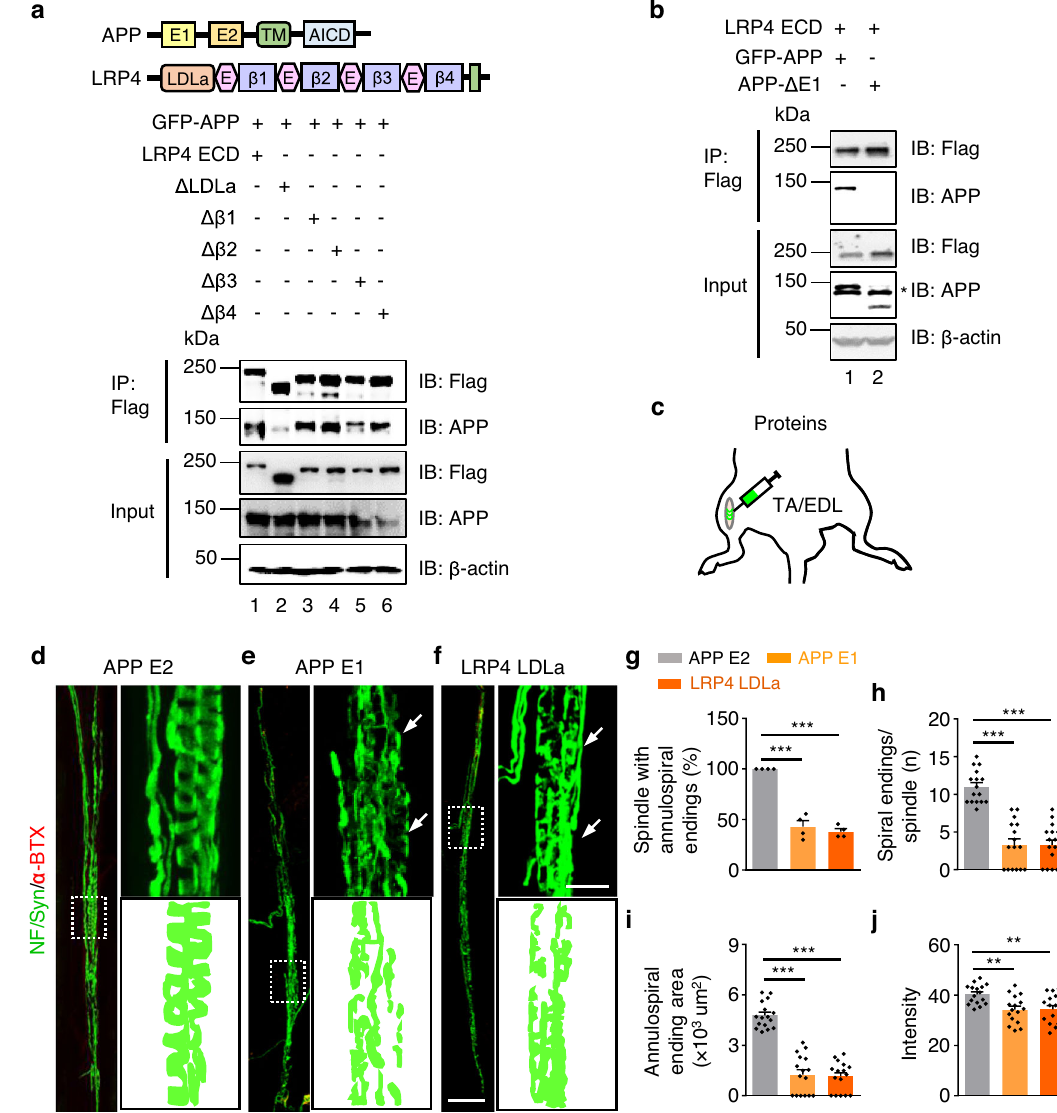
Fig. 7 | LRP4-APP trans interaction for muscle spindle structure. a , b Requirement of APP E1 and LRP4 LDLa for binding. a co-IP of GFP-APP co- transfected with Flag labeledLRP4 ECD, ECDdeleted with LDLa ( Δ LDLa), Δβ 1, Δβ 2, Δβ 3and Δβ 4.Thisexperimentwasrepeatedthreetimesindependentlywithsimilar results. b co-IP of LRP ECD co-transfected with GFP labeled APP or APP Δ E1. Asterisks, non-speci fi city bands. Uncropped blots in Source Data. This experiment was repeated three times independently with similar results. c Schematic diagram of recombinant proteins injection (P60). d – f Impaired annulospiral endings after theinjectionofrecombinantAPPE1and LRP4LDLa(P60).EDLmusclesinjectedby APP E2 ( d ), APP E1 ( e ) and LRP4 LDLa ( f ) recombinant proteins were whole mount stained with NF/Syn (green) and α -BTX (red). Arrows, the equatorial region of